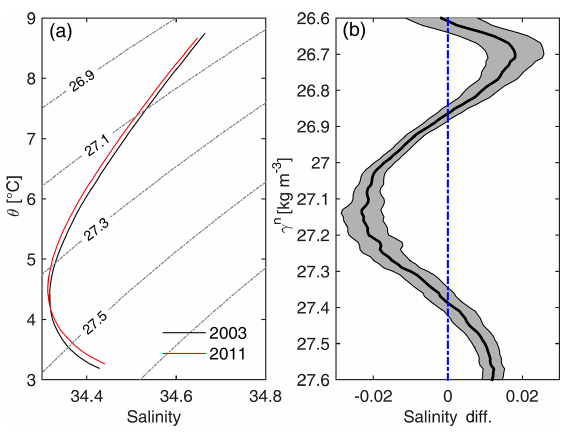
Figure 5. (a) The same as Fig. 3a but for sectional mean of WOCE hydrographic casts. The corresponding year for each θ – S curve is listed in the bottom-right corner. (b) Sectional mean differences (thick black line) of WOCE hydrographic data along γ n and their 95% confidence intervals (grey shadings, t test).